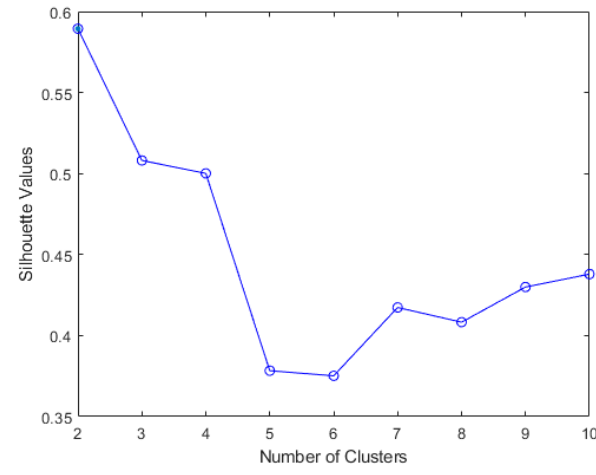
Figure 4. Silhouette score results for Ward clustering algorithm.